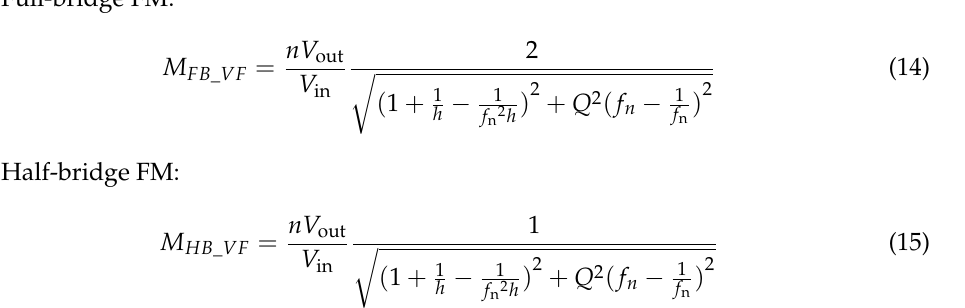
where Q = Z r /R ac represents the quality factor, h = L m /L r represents the inductance ratio, f n = f s /f r represents the normalized frequency, f s is the switching frequency and f r is the reso ‐ nant frequency.